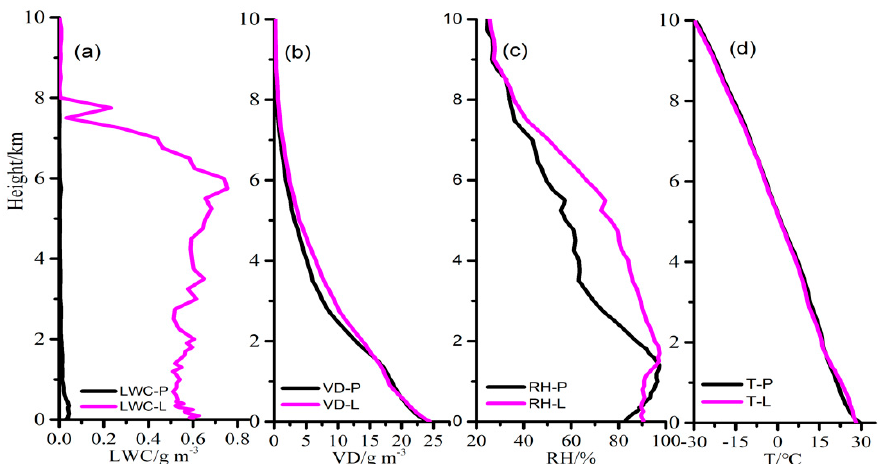
Figure 11. Same as Figure 9 but for Case 3 (Precipitation peak at 1400 LT and the maximum number of CG flashes at 0100 LT on 12 September 2014). The vertical profiles of liquid water content (LWC) ( a ), vapor density (VD) ( b ), relative humidity (RH) ( c ), and temperature (T) ( d ).